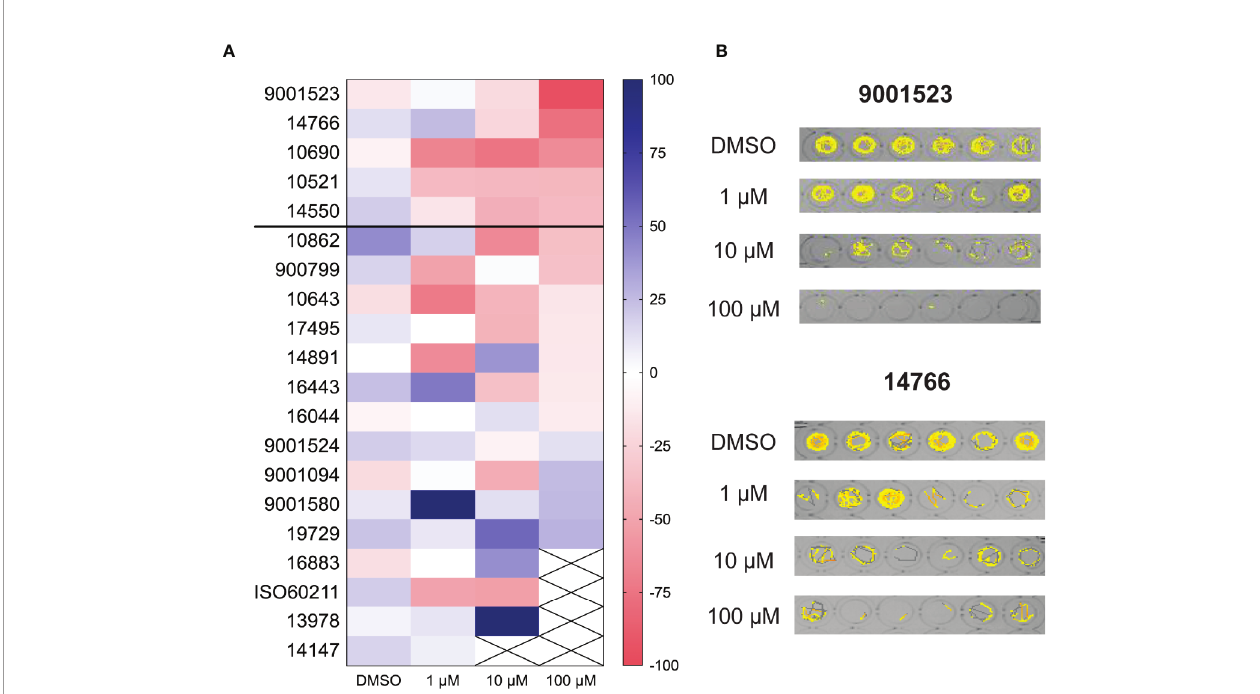
FIGURE 2 | Behavioral screening of 20 compounds which were identi fi ed as positive from the library screens. (A) Heat map representing the change of mean swim velocity of the 20 hit compounds. The 20 SCs which were identi fi ed from the blind screens were retested at 1, 10, and 100 µM to con fi rm a dose response effect. Each box represents the percent change in mean velocity from a locomotion assay on at least 6 scn1lab larvae. Compounds marked with a cross were identi fi ed as toxic; threshold for positive hits shown by solid line. Scale at right represents the range of % change in mean velocity values. (B) Representative swim behavior traces obtained during a 10 min recording epoch for the top two compounds, #9001523 and